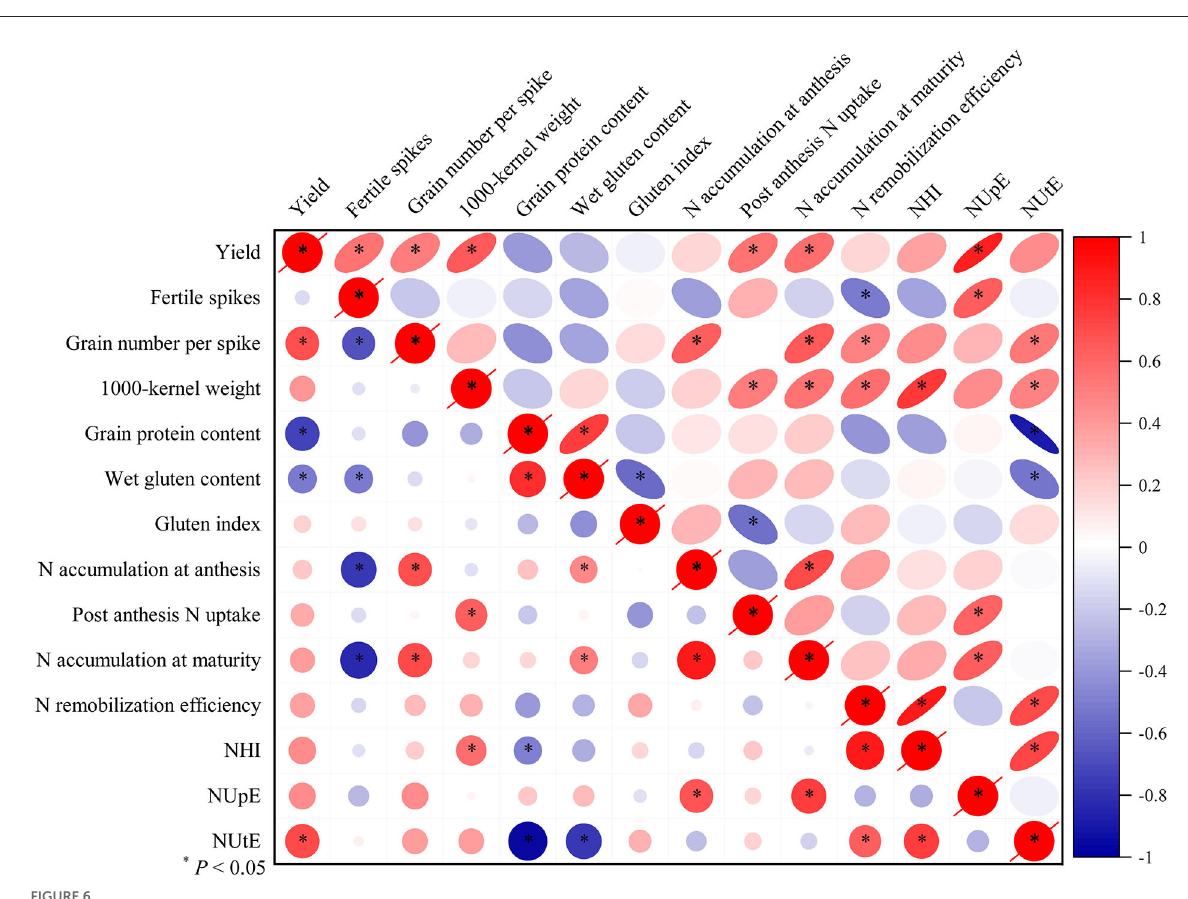
FIGURE6 The Pearson’s correlation analysis on yield, grain protein quality, and NUE-related traits. All values were measured with three replications ( n = 3), two-year data were pooled. N, nitrogen; NUpE, N uptake efficiency; NUtE, N utilization efficiency; NHI, N harvest index; R , Pearson’s R . * P < 0.05. Circles and ellipses represent SW and RW cropping systems,